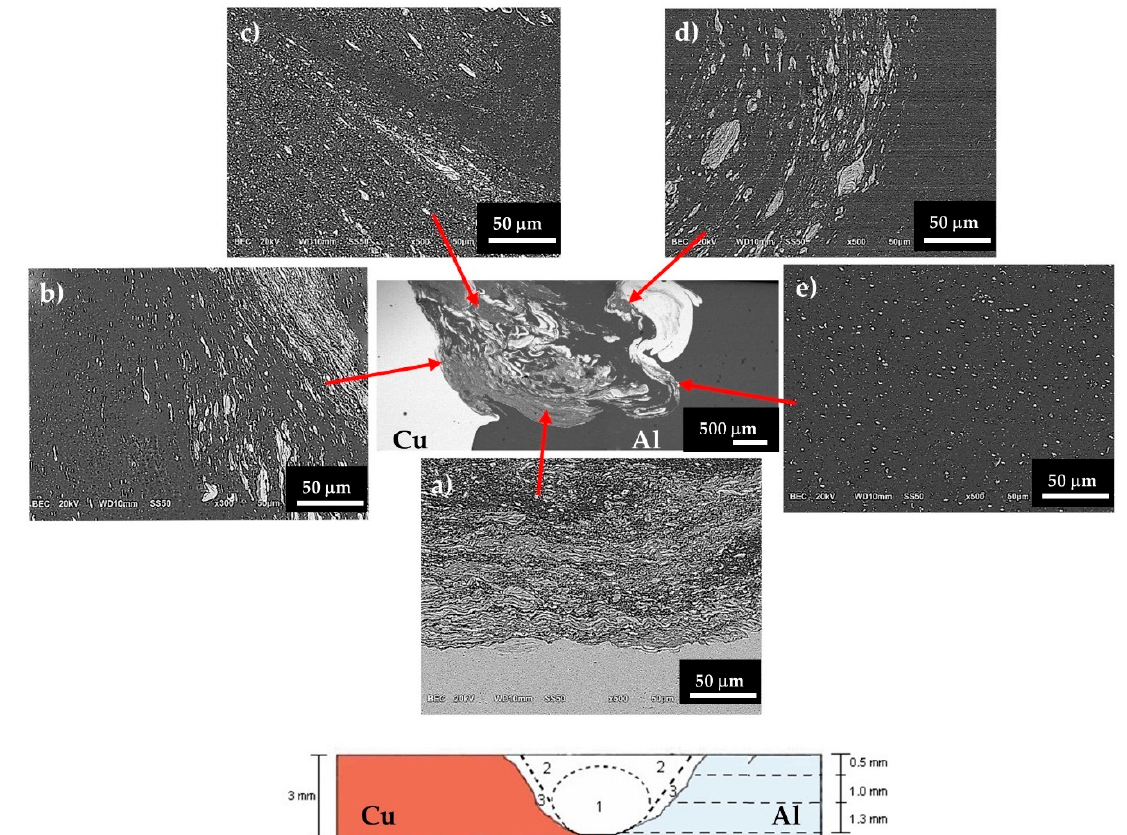
Figure 7. SEM micrographs of the cross section of the sample 1000_40. ( a ) nugget zone (DXZ), ( b ) heat affected zone (HAZ) Cu-side, ( c ) thermomechanically affected zone (TMAZ) Cu- side, ( d ) TMAZ Al-side, ( e ) HAZ Al-side.